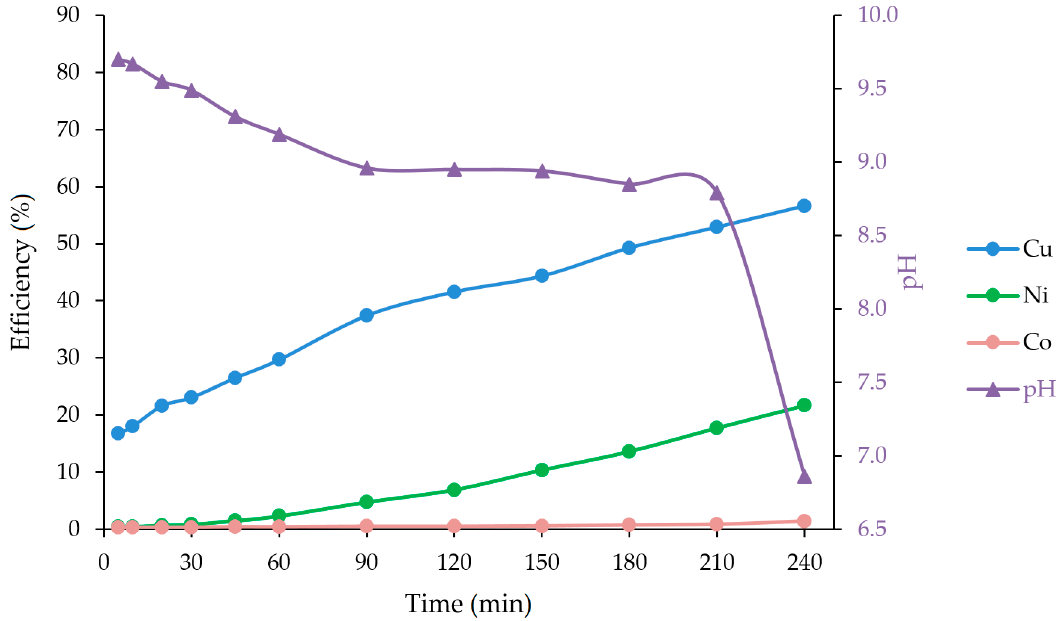
Figure 5. Kinetics of metals extraction during ammoniacal leaching with ultrasound at 50 °C.